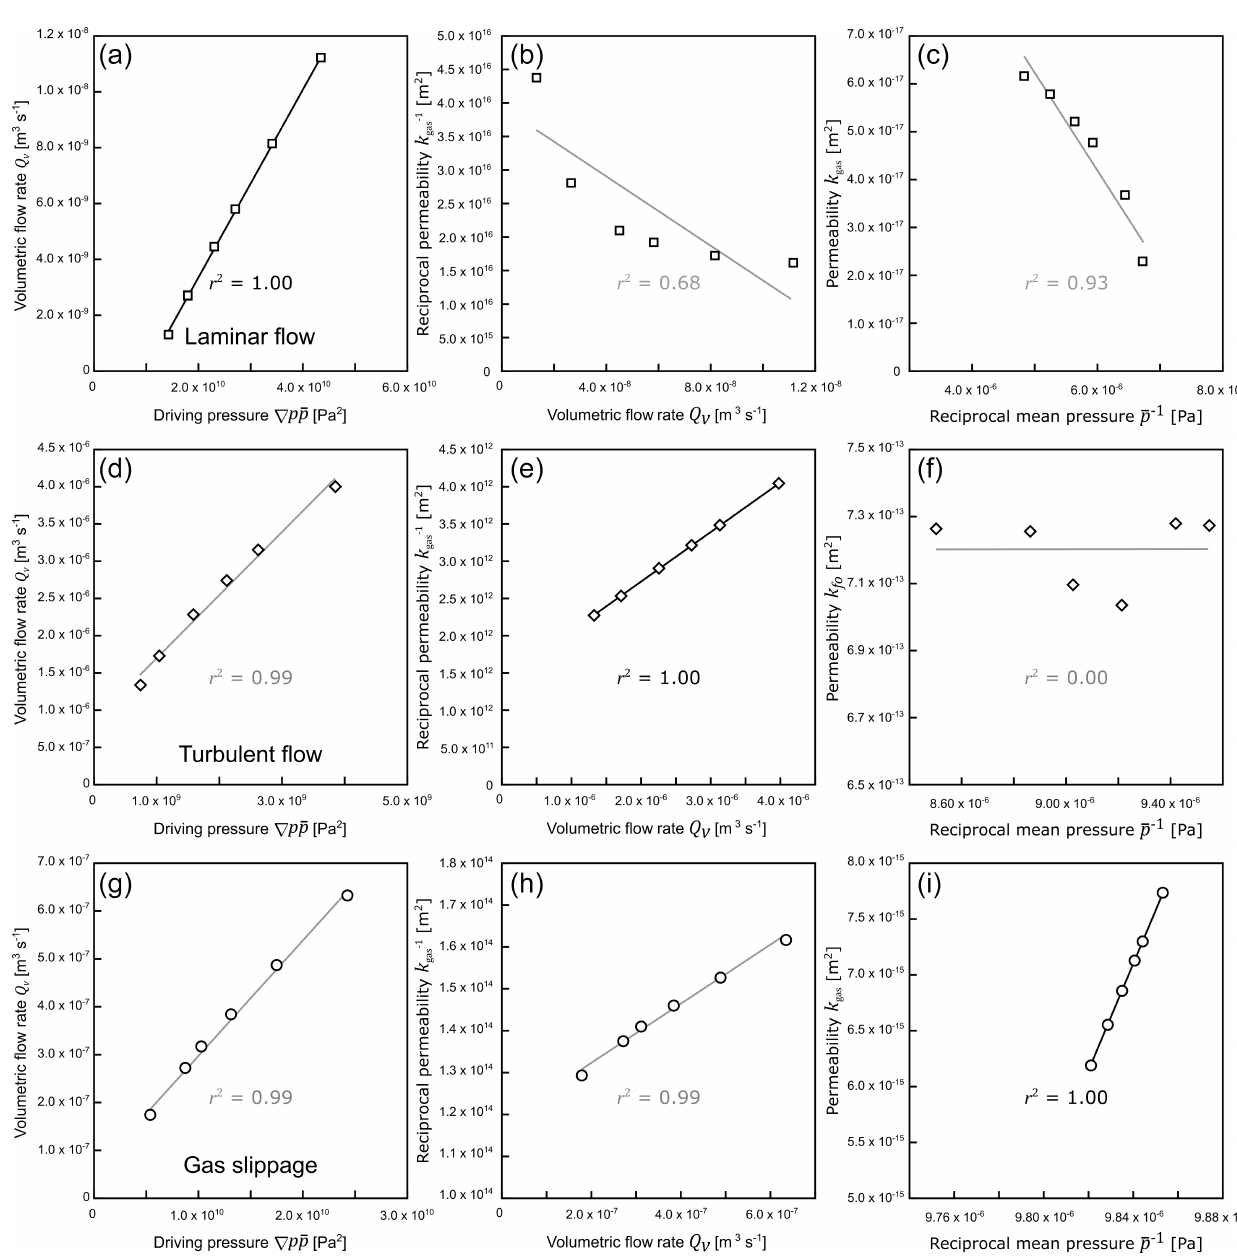
Figure A1. Flow and pressure data. Data obtained during permeability measurements on three rocks. (a–c) Laminar flow in a sample from Whakaari, New Zealand. (d–f) Turbulent flow, in a sample of Ruapehu andesite (New Zealand). (g–i) A small gas slippage effect in a sample of Açores